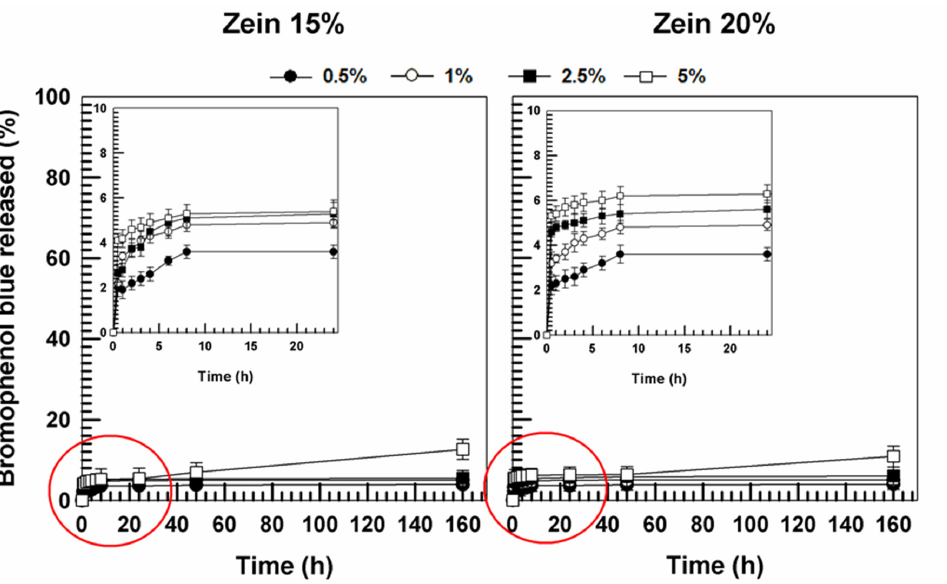
Figure 13. Release profile of bromophenol blue from zein gels (15%, 20% w/v ) as a function of the amount of entrapped drug and time. Values represent the mean of three different experiments ± standard deviation.